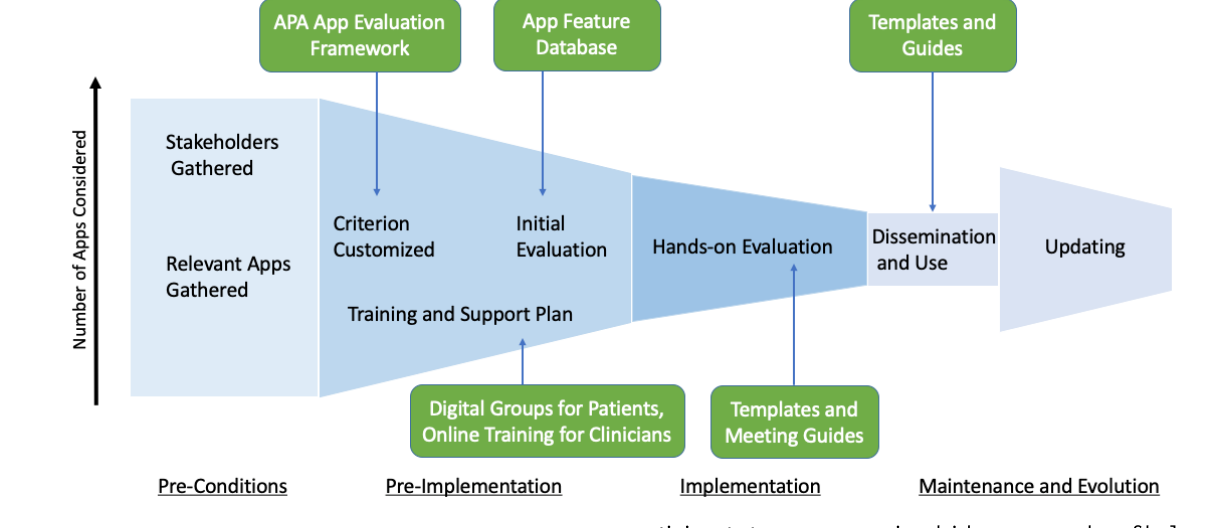
Figure 1. Schematic of the TEACH-apps model for implementing app evaluation. This model presents the app evaluation process step-by-step from left to right. The height of each TEACH-apps stage represents the number of apps considered. The preconditions stage has the largest height because it involves the initial gathering of all of the apps to be considered. After apps have been evaluated within the implementation stage, apps that meet the criteria are disseminated in the maintenance and evolution stage. The ‘updating’portion of the final stage, which occurs 90 days from the dissemination period, has an increased height to account for new apps that may have surfaced or apps that have improved since the dissemination period. APA: American Psychiatric